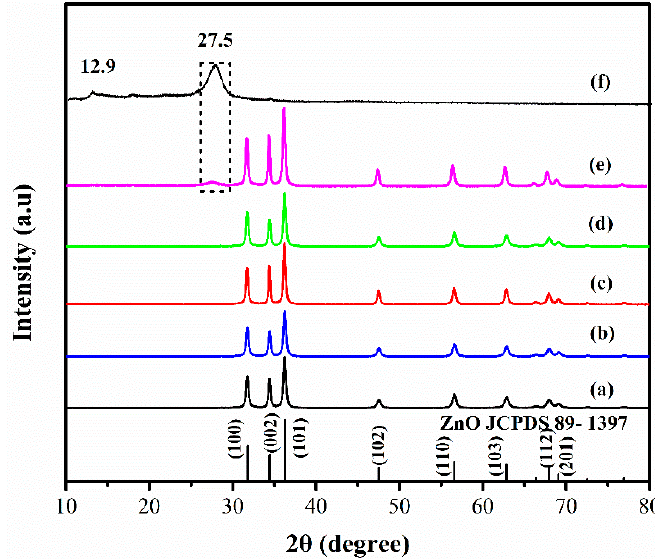
Figure 3. XRD patterns of the prepared samples: ( a ) pure ZnO, ( b ) CNZ-1, ( c ) CNZ-3, ( d ) CNZ-5, and ( e ) g-C 3 N 4 / ZnO composites with a g-C 3 N 4 content of 20 wt %, ( f ) g-C 3 N 4